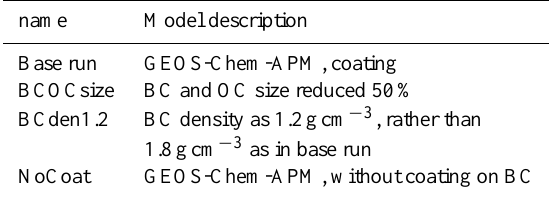
Table 6. Description of base run and sensitivity runs.